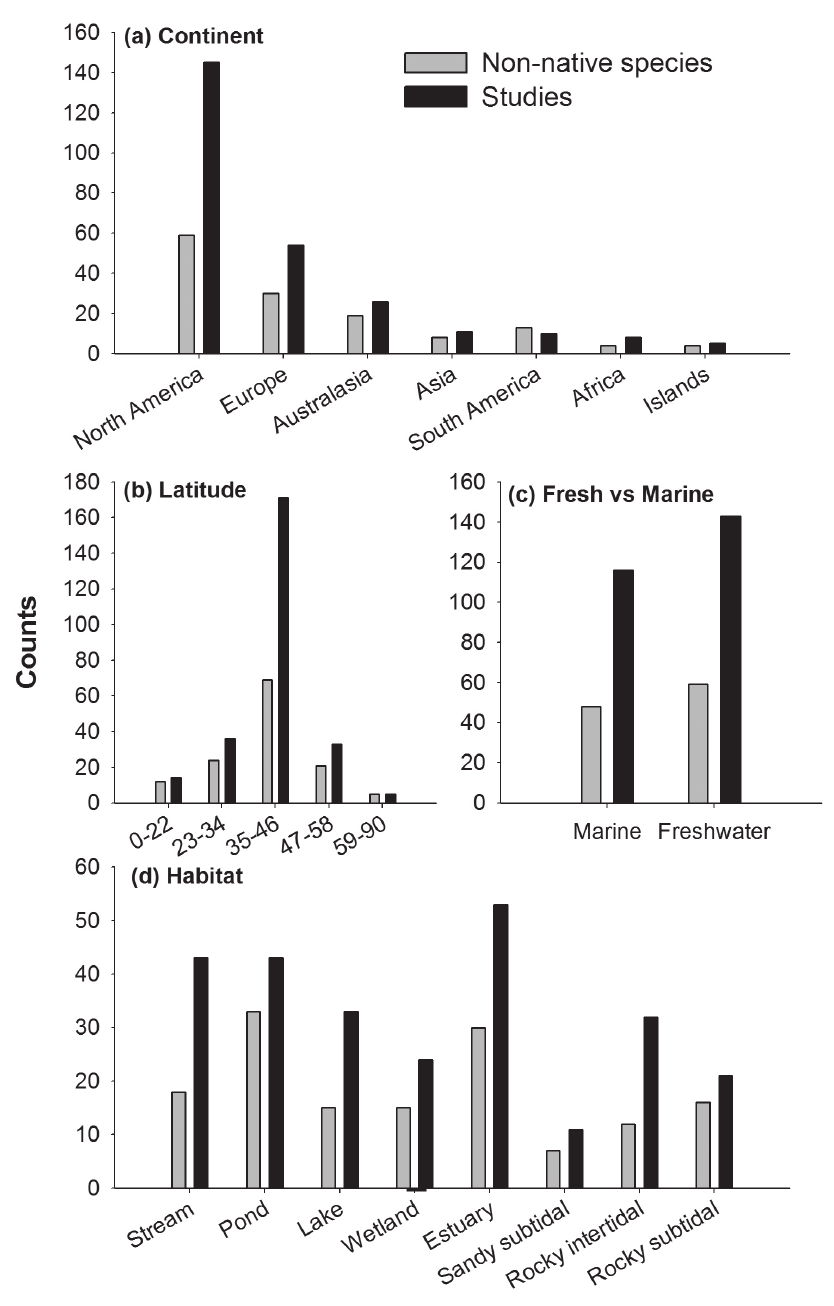
Figure 4. Aquatic invasion impact experiments classified by the attributes of the invaded system. Grey bars correspond to number of non-native species studied out of 105 taxa, and black bars correspond to the number of scientific studies out of 259. The invaded system was classified according to a continent b latitude c if it was a marine or freshwater system, and d